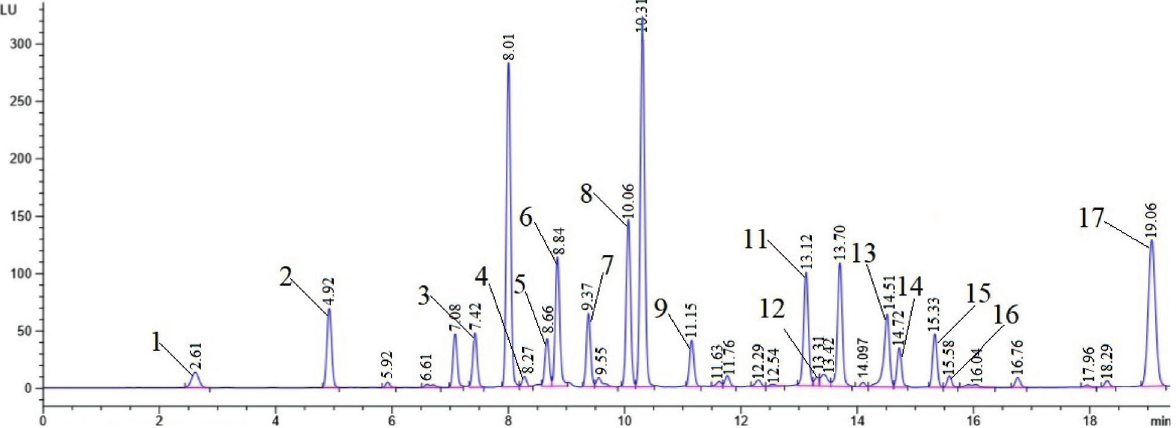
Figure 3. HPLC chromatogram of free amino acids of Stahys sieboldii tubers.